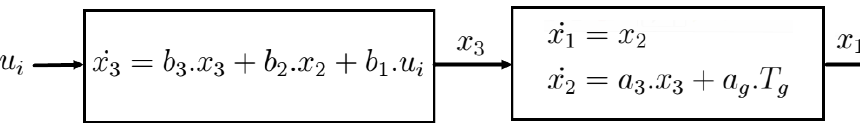
Figure 30. The electrical and mechanical